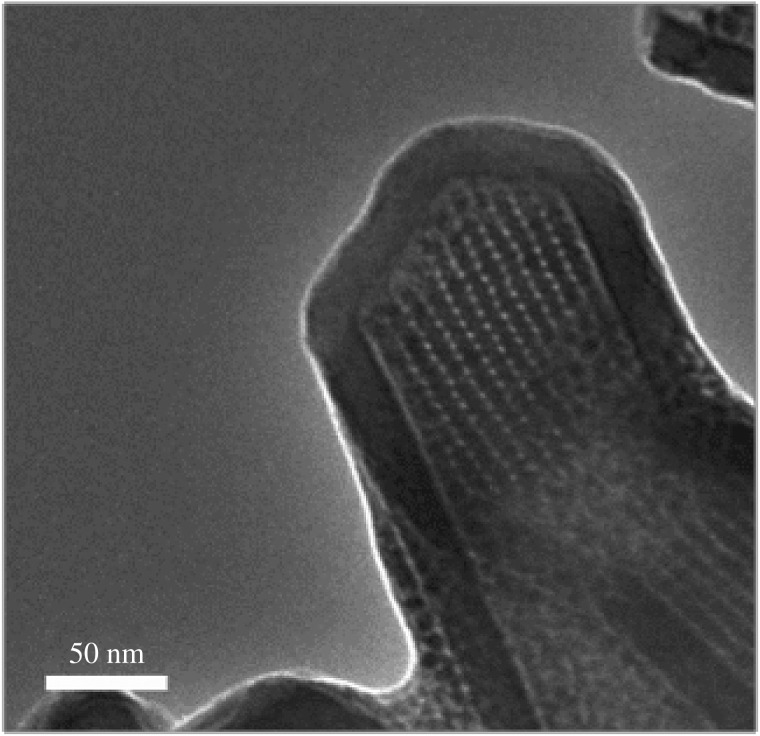
Si NT loaded with Fe3O4 NPs, illustrating the closest packing of the nanocrystals inside the tube.